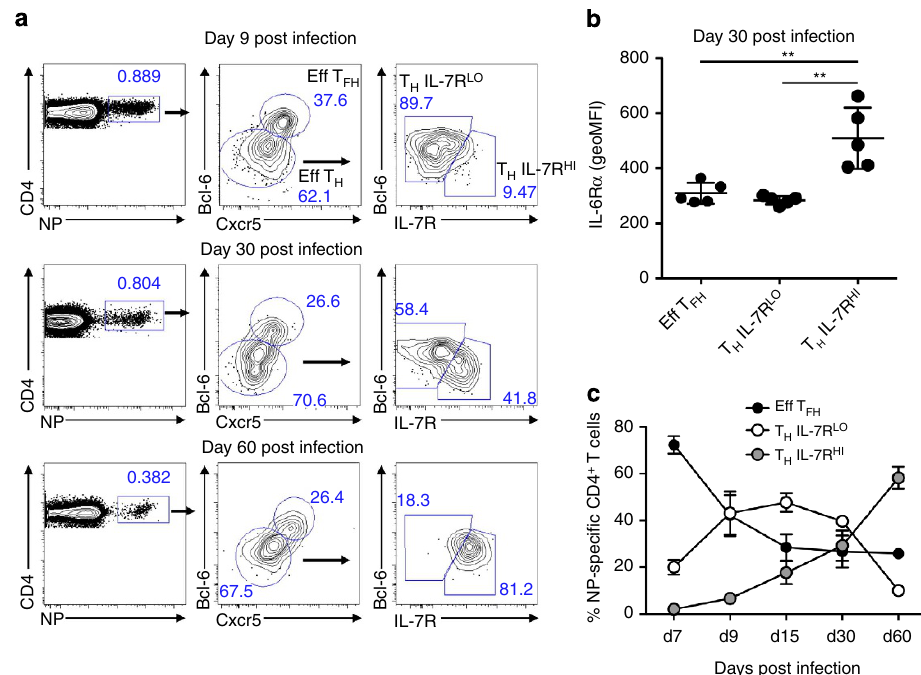
Figure 7 | IL-6R a þ IL-7R þ CD4 þ T cells are detected at late time points post influenza infection. Mice were infected with influenza (PR8) and CD4 þ CD19 (cid:2) Foxp3 (cid:2) cells were analysed by flow cytometric analysis at the indicated day post infection. ( a ) Nucleoprotein (NP)-specific cells were isolated and sorted into effector T FH (Eff T FH ) and non-T FH (Eff T H ) populations. Non-T FH effector cells were then assessed for IL-7R expression and further classified as IL-7R low (IL-7R LO ) or IL-7R high (IL-7R HI ). ( b ) IL-6R a expression of the indicated cell population was measured by flow cytometric